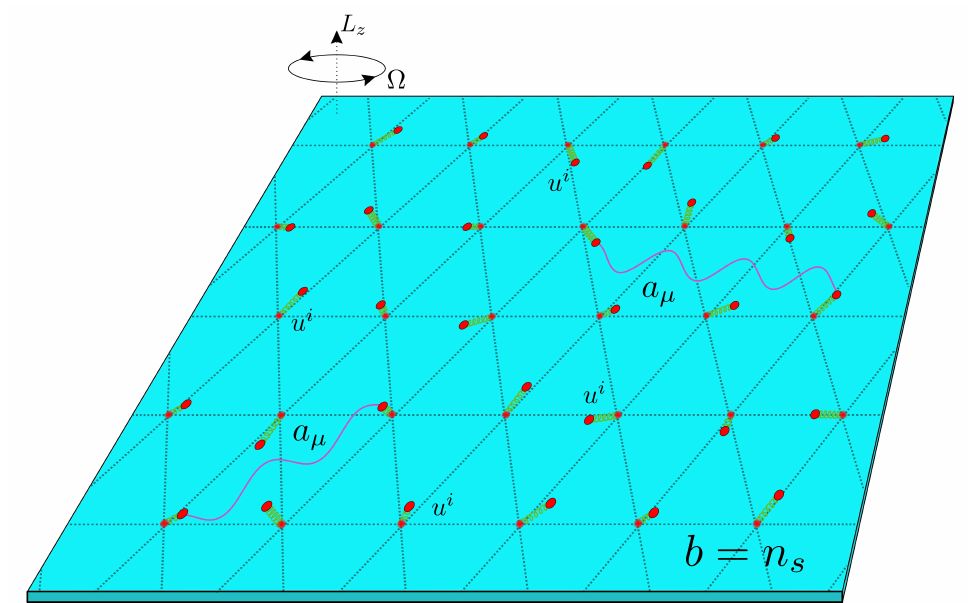
Figure 1: Dual Wigner crystal: point charges (red dots) form a triangular lattice in a homogenous neutralizing background (cyan). Microscopic displacements and photons of the dual gauge field are represented by green springs and violet wavy lines, respectively. Degrees of freedom u i and a µ of the effective theory (1) are coarse- grained averages over large number of unit